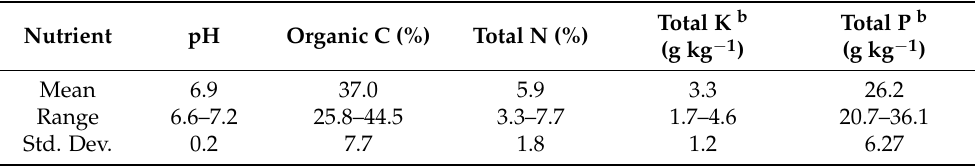
Table 6. Mean, range and variability of nutrient concentrations a in stabilized sewage sludge collected from different Croatian wastewater plants.